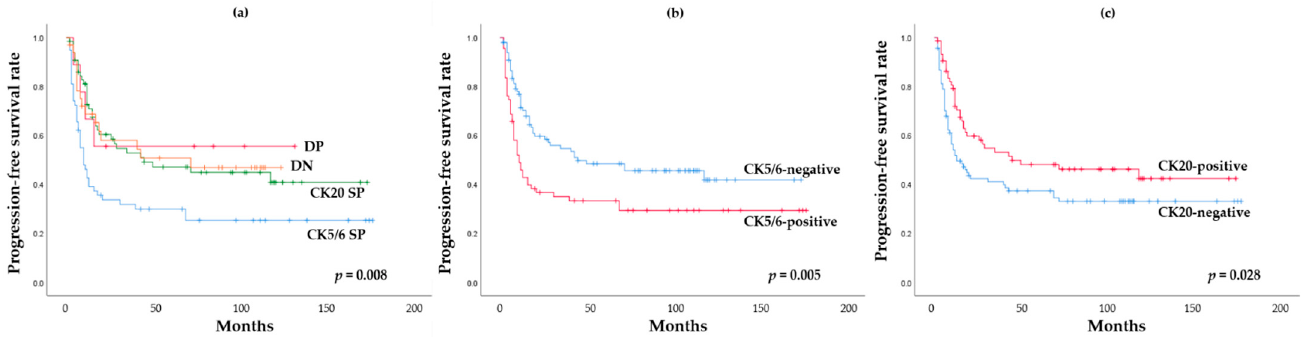
Figure 5. Progression free survival analysis: ( a ) impact of IHC-based classification; ( b ) impact of CK5/6 expression; ( c ) impact of CK20 expression.